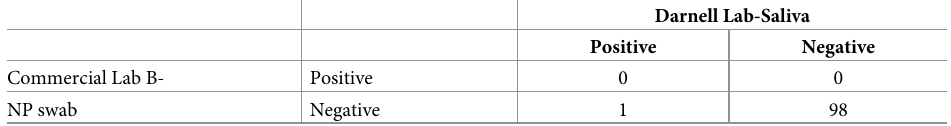
Table 3. Comparison of SARS-CoV-2 DRUL assay with commercially tested NP